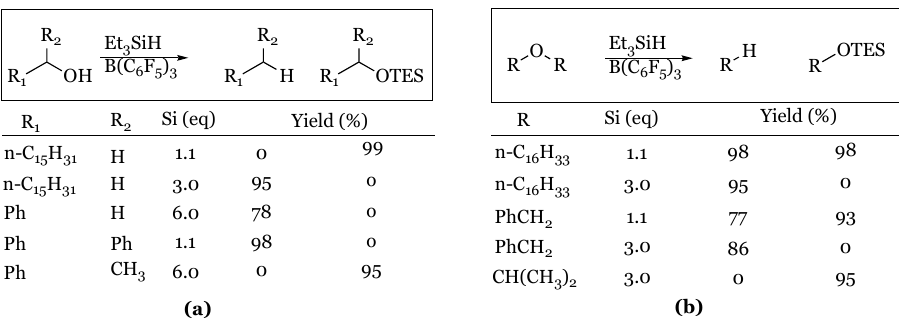
Figure 1. Representative reductions with triethylsilane: ( a ) alcohols; ( b ) ethers.